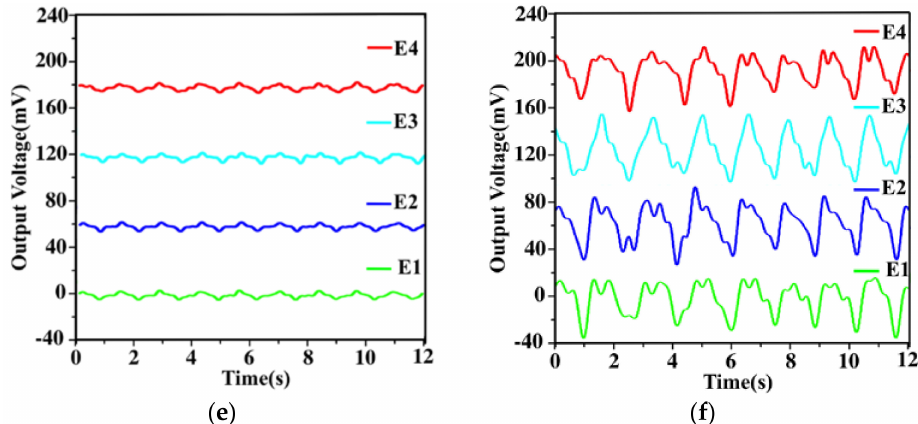
Figure 4. ( a ) The open circuit voltage under the force of 18 N. ( b ) The relationship of open circuit voltage with applied normal force. ( c ) The open circuit voltage on E1–E4 electrodes (M-A). ( d ) The open circuit voltage on E1–E4 electrodes (M-B). ( e ) The output voltage on the four electrodes under normal force of 1.5 N. ( f ) The output voltage on the four electrodes under the normal force of 10 N.